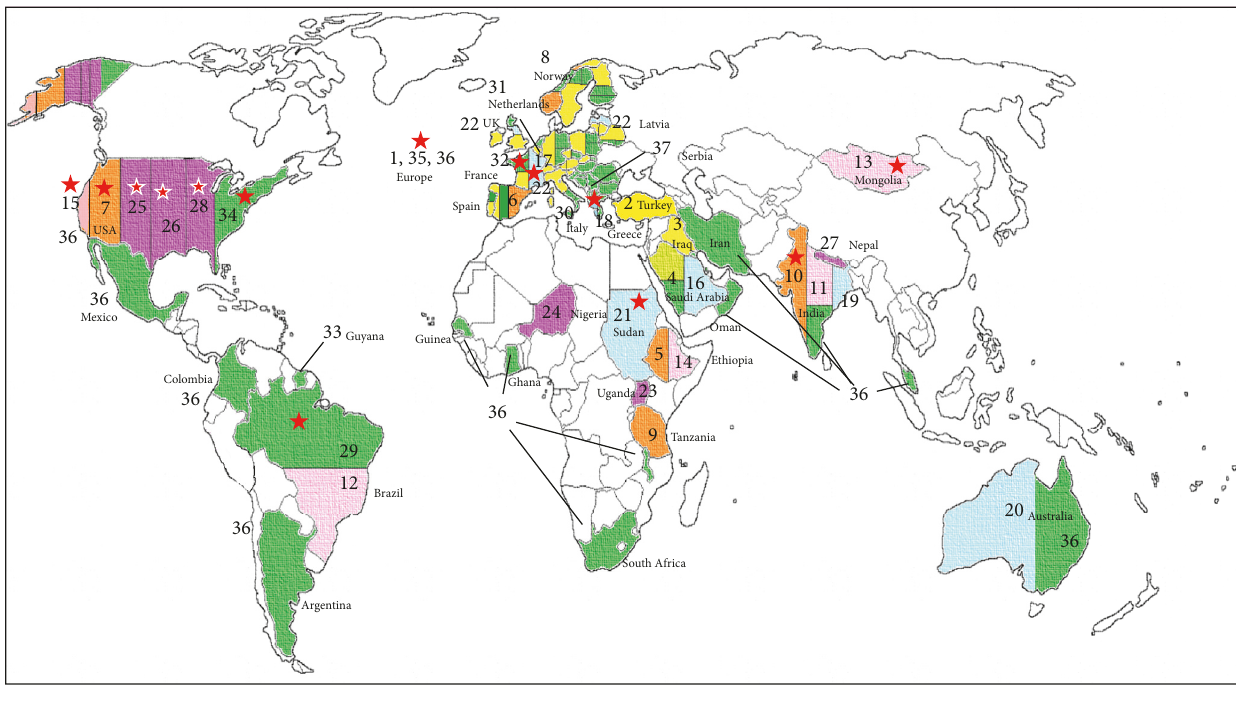
Figure 2: World map of papers on CAP treatment in children stratified by year of